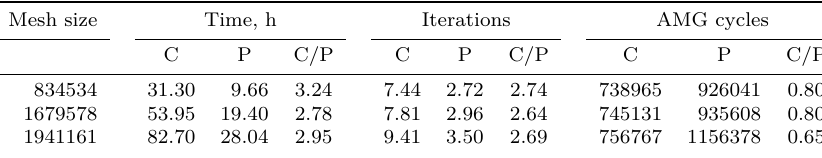
Computational performance of the coupled (C) and PISO (P) schemes solving the aortic valve problem: total solution time in hours, average number of iterations per time step and total number of AMG cycles Mesh size Time, h Iterations AMG cycles C P C/P C P C/P C/P